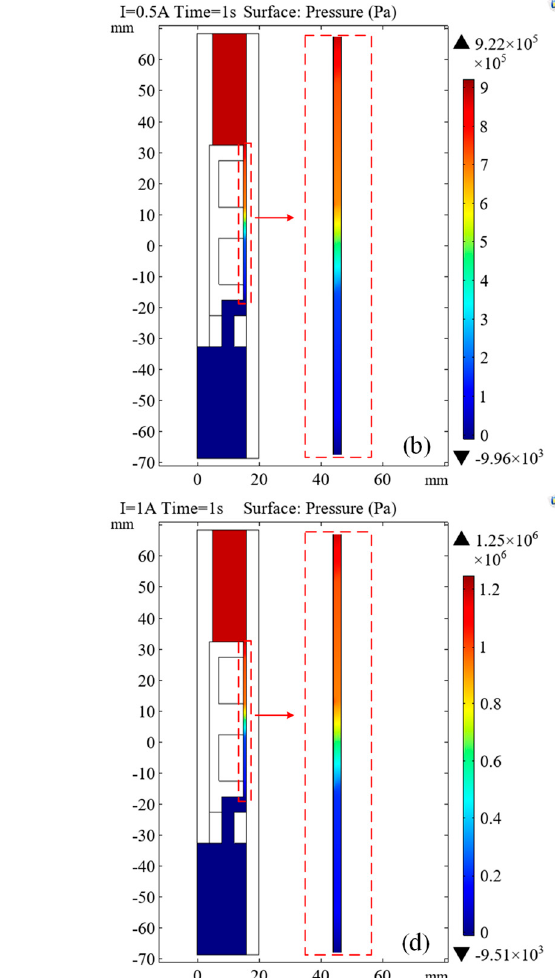
Figure 7. Pressure distribution for: ( a ) I = 0.25 A; ( b ) I = 0.5 A; ( c ) I = 0.75 A; and ( d ) I = 1 A.